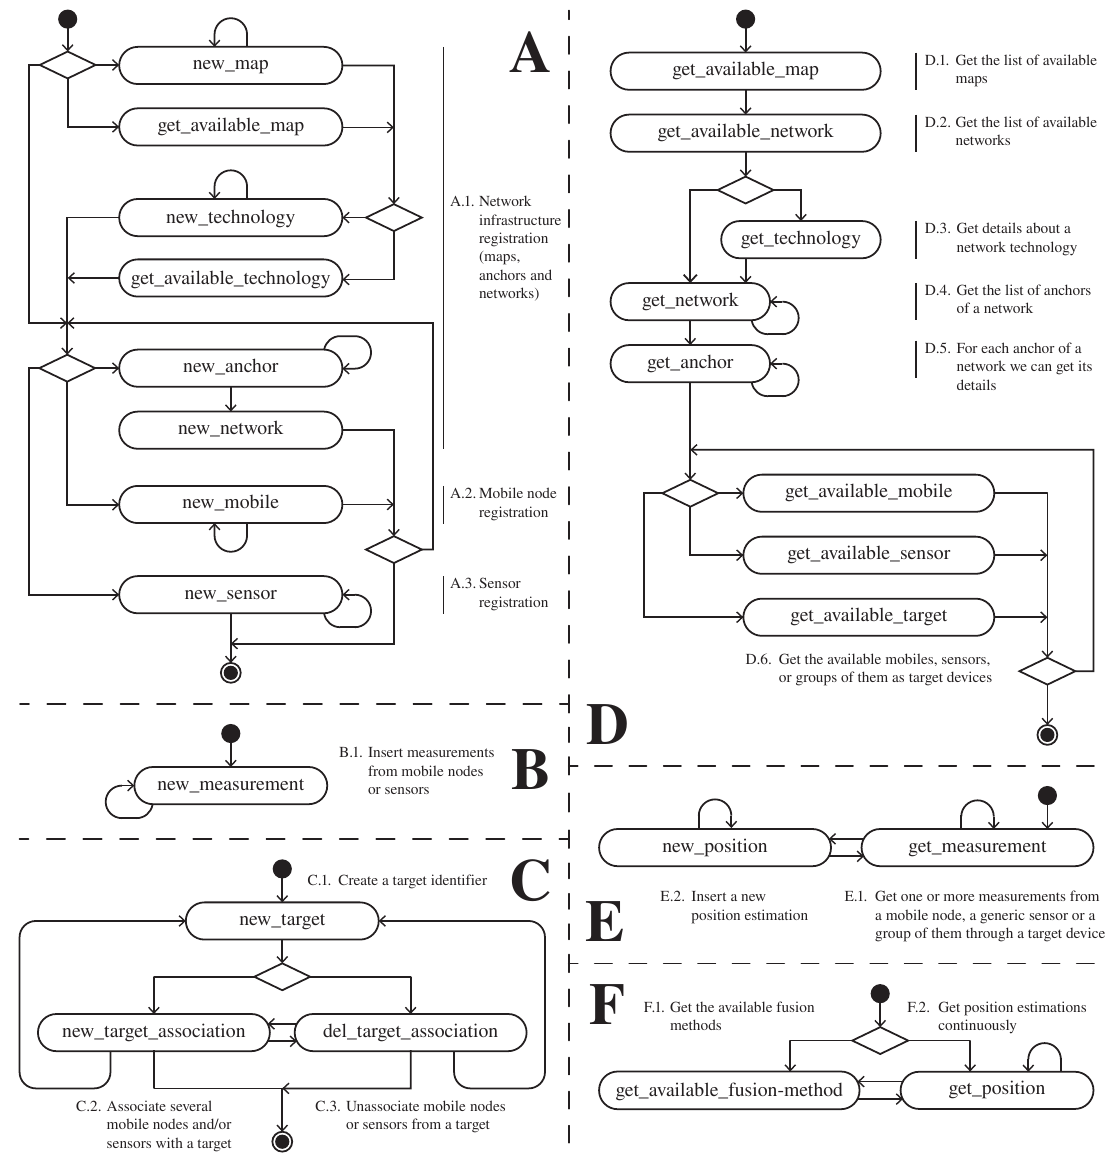
Figure 3. Workflow of the proposed system divided into six groups of messages: ( A ) Infrastructure (maps, anchor and network), mobile node and sensor registration process; ( B ) New measurements from mobiles or sensors; ( C ) Target administration with association to mobiles and/or sensors; ( D ) Location algorithm initialization steps to know the elements available; ( E ) Position estimation process where, a location algorithm estimates new positions after reading measurements; ( F ) The localization clients continuously get position estimations, optionally filtering and merging positioning